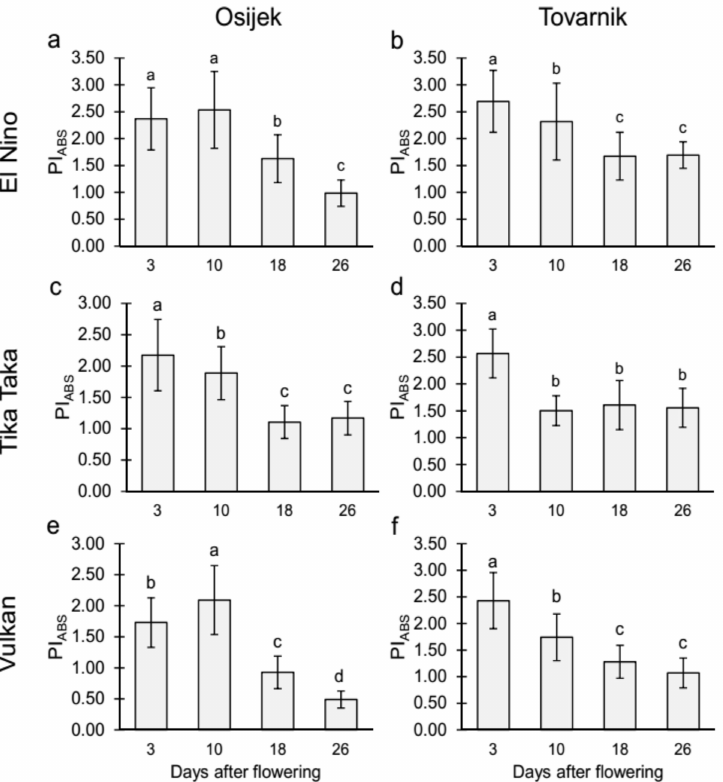
Figure 7. Performance index (PI abs ) presented as mean value ± standard deviation of 20 wheat heads of variety El Nino ( a , b ), Tika Taka ( c , d ), and Vulkan ( e , f ) through four measurement points at two locations separately (Osijek and Tovarnik). Standard deviations are presented as vertical bars. Lower-case letters above columns are used to present results of statistical data analysis obtained by Fisher’s LSD test and point to statistically significant difference ( p < 0.05) between values of PI abs measured at 3, 10, 18, and 26 days after flowering for each wheat variety separately and at each